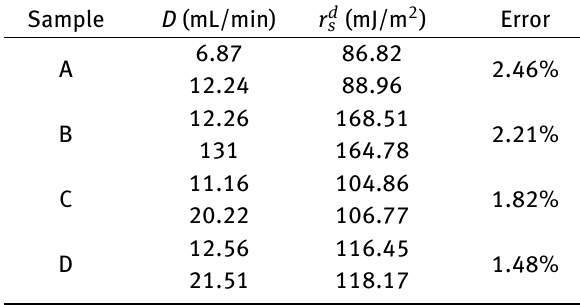
Table 3: r d s at different carrier gas flow rates